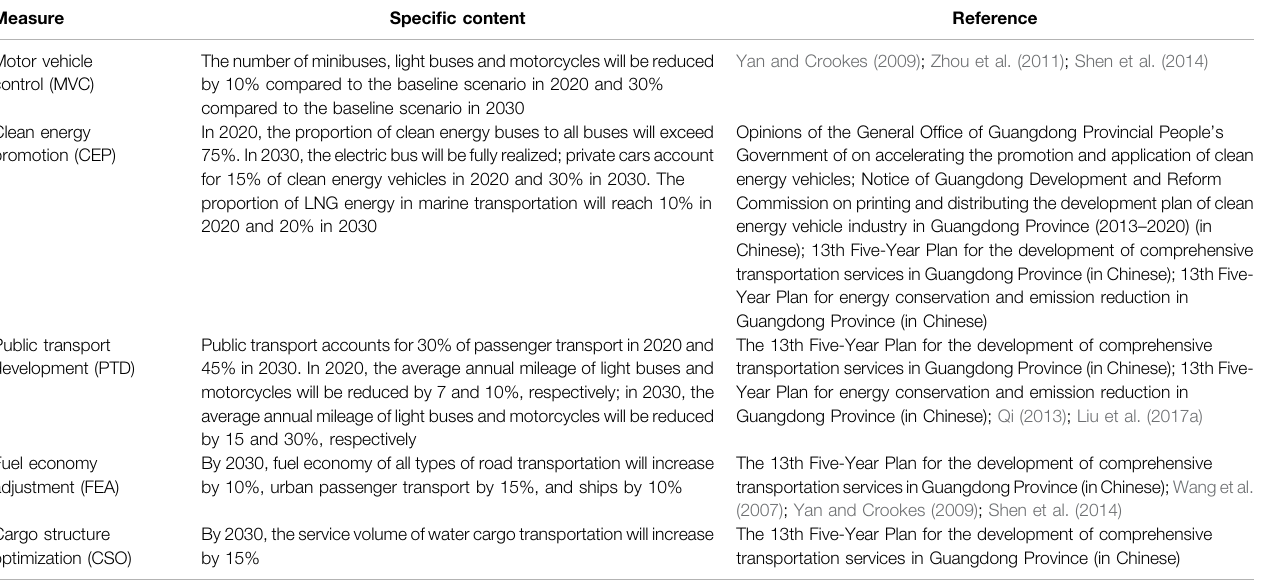
TABLE 1 | Low-carbon scenario design of transportation sector carbon emission policy in Guangdong Province.